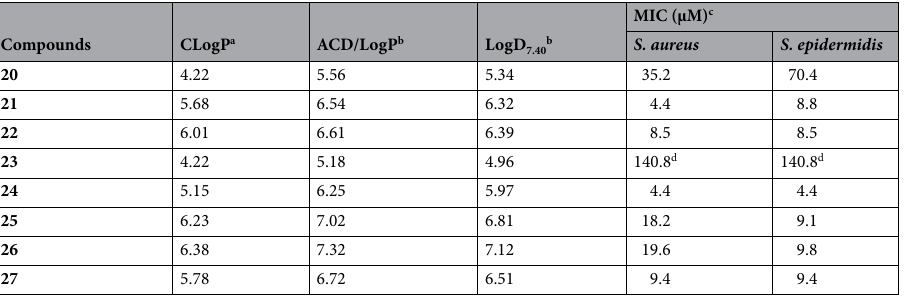
Table 2. Physico-chemical parameters and antimicrobial activities of compounds 20 to 27 11 . a The CLogP values were calculated using software ChemBioDraw Ultra 12.0. b The ACD/Log P and LogD 7.40 values were calculated using software ACD/Labs 6.0. c MIC, minimum inhibitory concentration; S. aureus , Staphylococcus